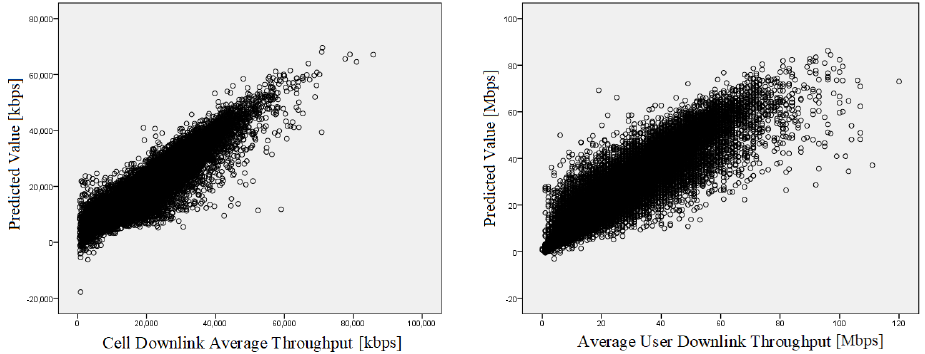
Figure 7. Scatter plots of the model testing results.